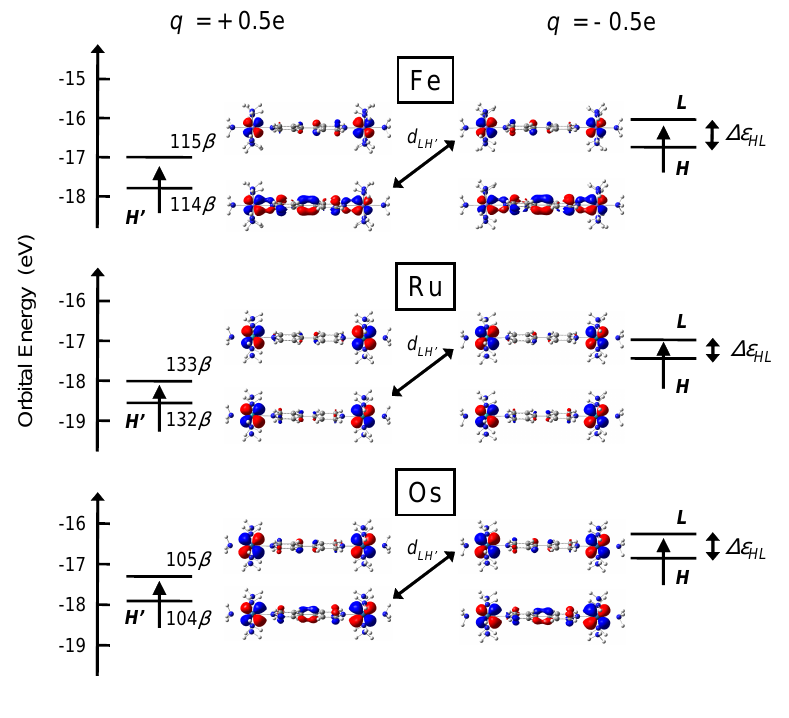
Figure 5. HOMO and LUMO with β spin of bpy complex when q = +0 . 5 e (left) and q = − 0 . 5 e